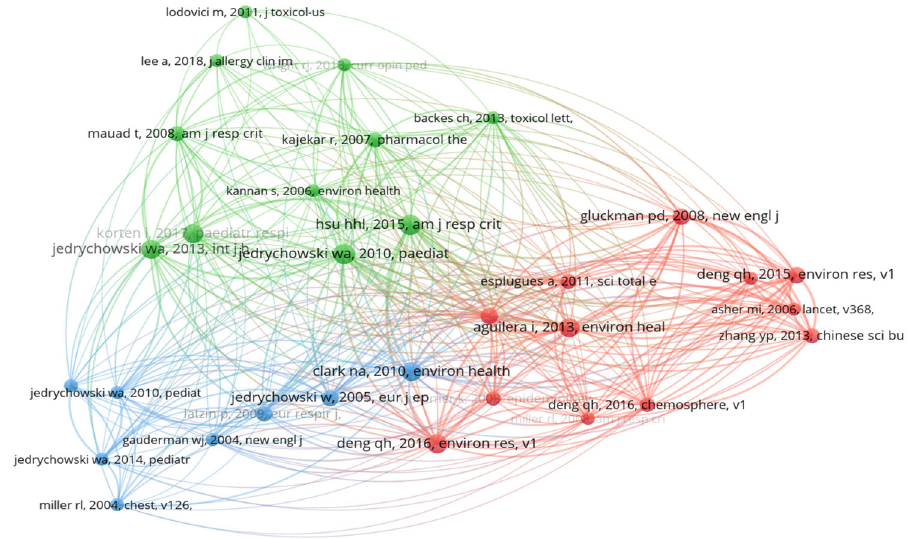
Figure 11. Reference co ‐ citation